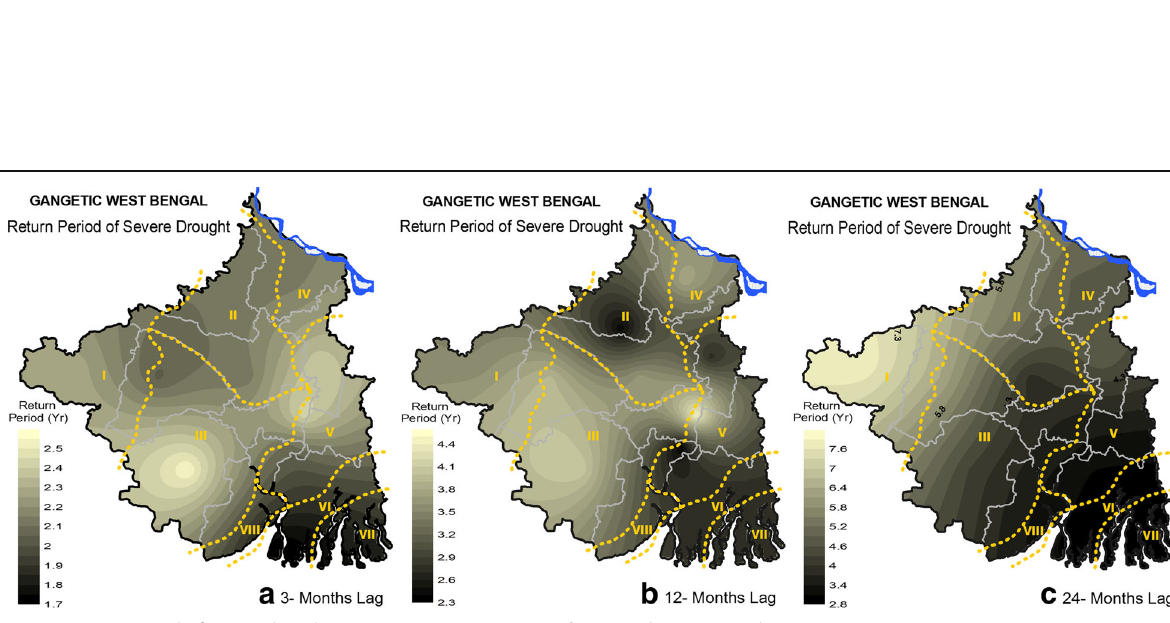
Fig. 14 Return period of severe drought (SPI <-1.5 to -1.99) on ( a ) 3- ( b ) 12- and ( c ) 24- months time